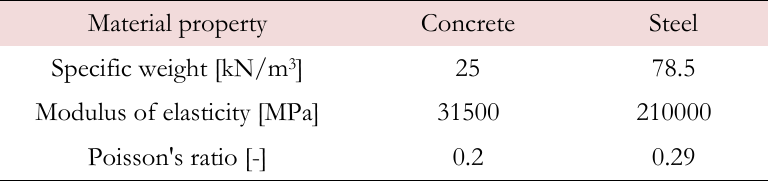
Table 3: Material properties of reinforced concrete and steel.